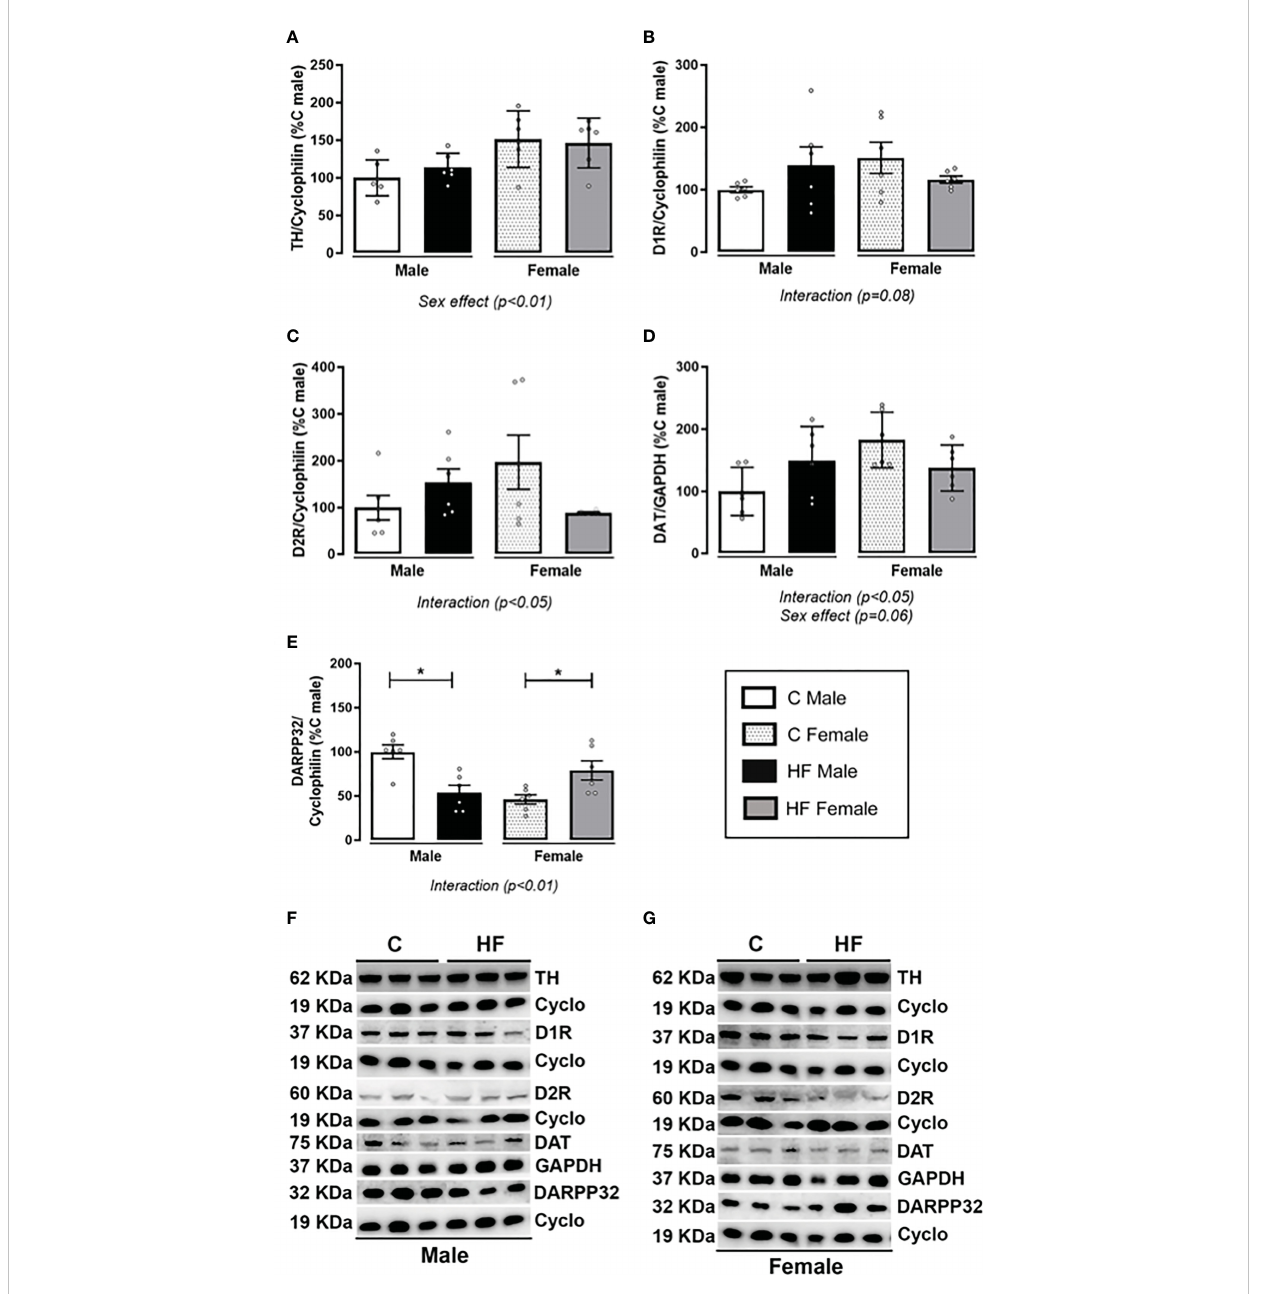
FIGURE 7 Effect of maternal high-fat (HF) diet on the dopamine signaling in the Nucleus Accumbens (NAc) of weanling offspring. (A) Tyrosine hydroxylase (TH); (B) type-1 dopamine receptor (D1R); (C) type-2 dopamine receptor (D2R); (D) dopamine transporter (DAT); and (E) cAMP-regulated neuronal phosphoprotein-32 kDa (DARPP-32) protein content in the NAc of control (C) and HF male and female offspring at weaning. (F) and (G) show the representative blots. Data are expressed as percentage of control male group (set at 100%) ± standard deviation. Statistically signi fi cant differences were determined by two-way ANOVA followed by Bonferroni ’ s test. * p < 0.05